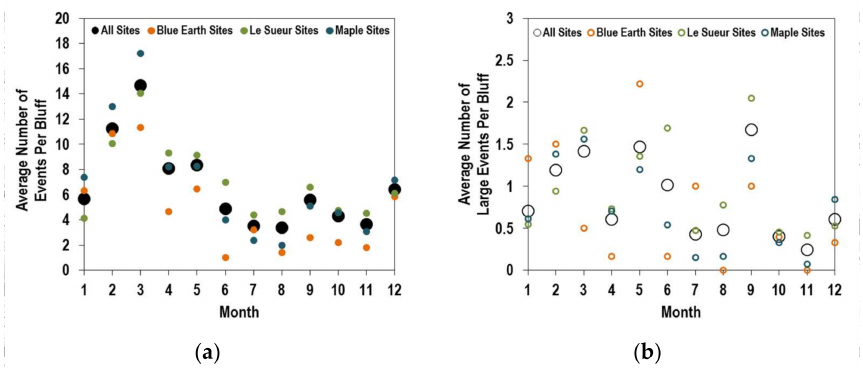
Figure A2. ( a ) Average number of failure days per month for a bluff of average size 250 m 2 (length × height). Average monthly days with failures are plotted for sites grouped by each river and for all bluff sites. Total number of observations: 2705 events; ( b ) average number days with large failures per month for sites grouped by each river and for all bluff sites. Number of observations: 347